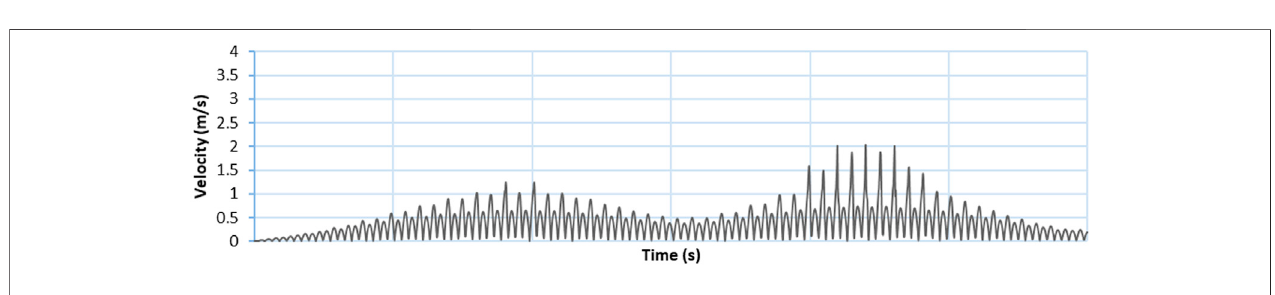
FIGURE 5 | Velocity pro fi le of alderney race with the friction coef fi cient of 0.01.